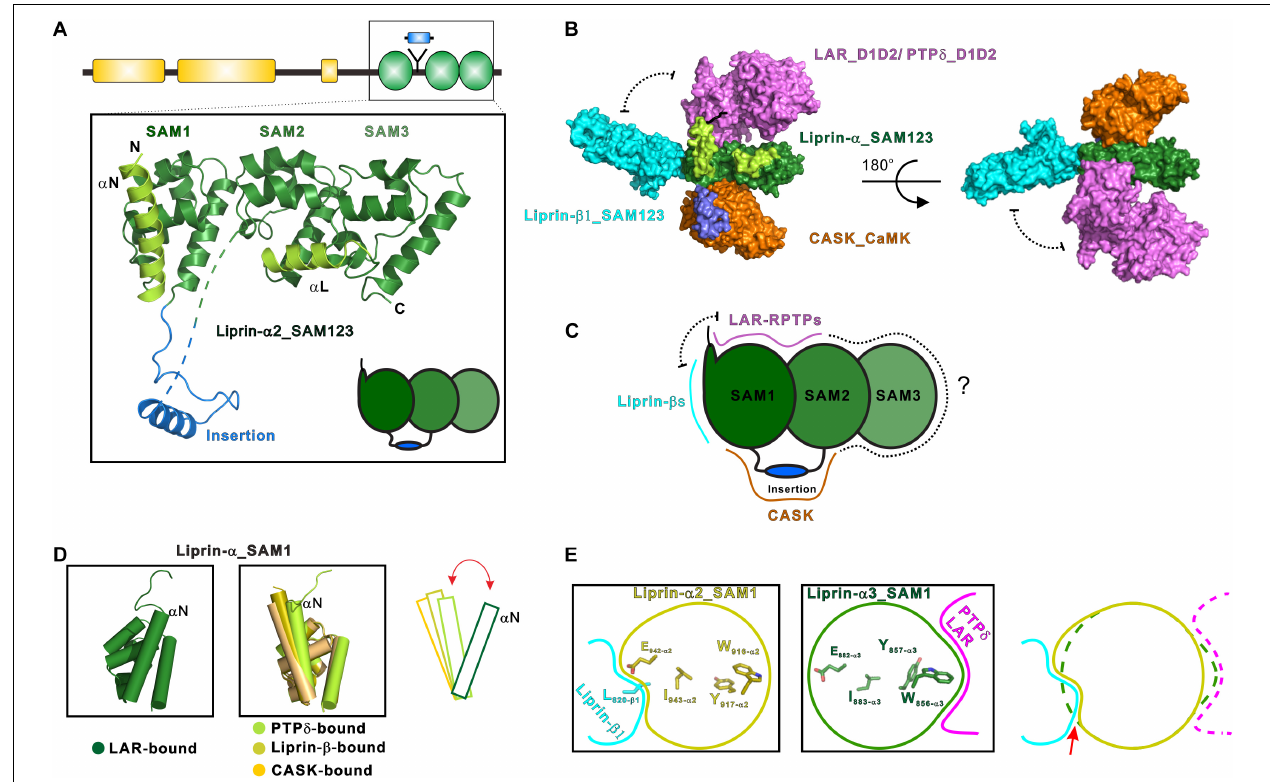
FIGURE 2 | Liprin- α SAM123 mediates supramolecular assemblies. (A) The structure of liprin- α SAM123. The SAM123 structure is derived from the liprin- α 2/CASK complex (PDB id: 3TAC). (B) A structure model showing the SAM123-mediated protein assembly. The SAM123 structures in complex with CASK (PDB id: 3TAC), liprin- β 1 (3TAD), and LAR (6KR4) are superimposed. (C) A schematic model indicates the target-binding surfaces of the liprin- α SAM123. Some surface patches on SAM2 and SAM3 may be also involved in protein binding. (D) Conformational dynamics of the α N-helix in the SAM1 domain. The rotational change of α N was indicated by a red bidirectional arrow. (E) Allosteric regulation of the binding of the liprin- α SAM123 to liprin- β 1 and LAR-RPTPs. The SAM1 residues that are involved in the allosteric regulation were shown as sticks. The conformational propagation of these SAM1 residues upon LAR-RPTP binding leads to the clash (indicated by a red arrow) between the liprin- α SAM1 and liprin- β 1 and thus blocks the liprin- α / β